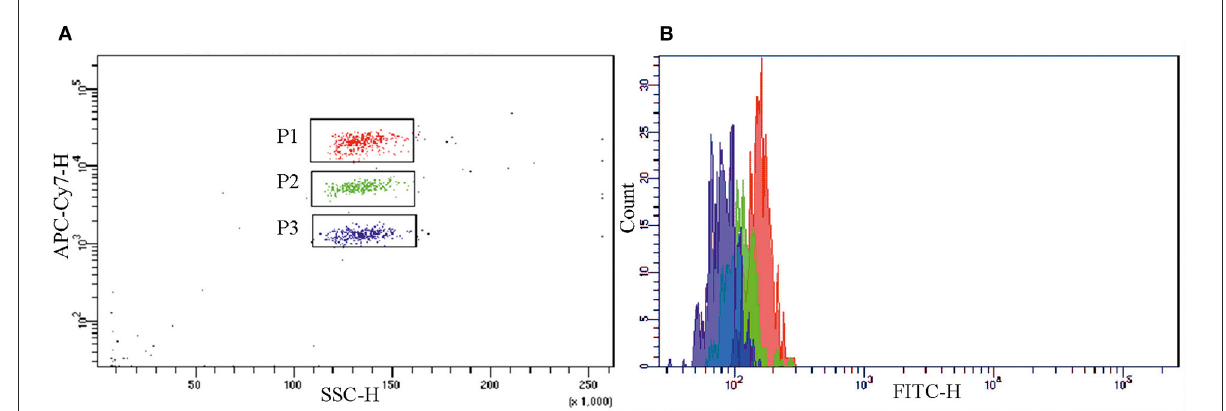
FIGURE1 Background fluorescence intensity from the A5 (gate P1), C4 (gate P2) and E5 (gate P3) beads, conjugated to the monoclonal antibodies clones MOH 328 (anti-pCRP/mCRP), 8C8 (anti-mCRP), MOH372 (anti-pCRP), respectively, in (A) the APC-Cy7 channel and (B) the FITC channel in the absence of mCRP or pCRP and in the presence of polyclonal FITC-labeled antibody to CRP (GAHCRP-FITC). mCRP, monomeric C-reactive protein; pCRP, pentameric C-reactive protein.